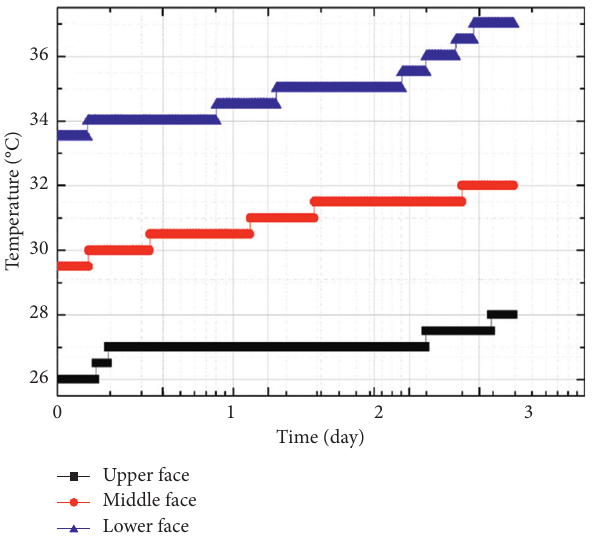
Figure 15: Trends of hydration temperature at different positions in the